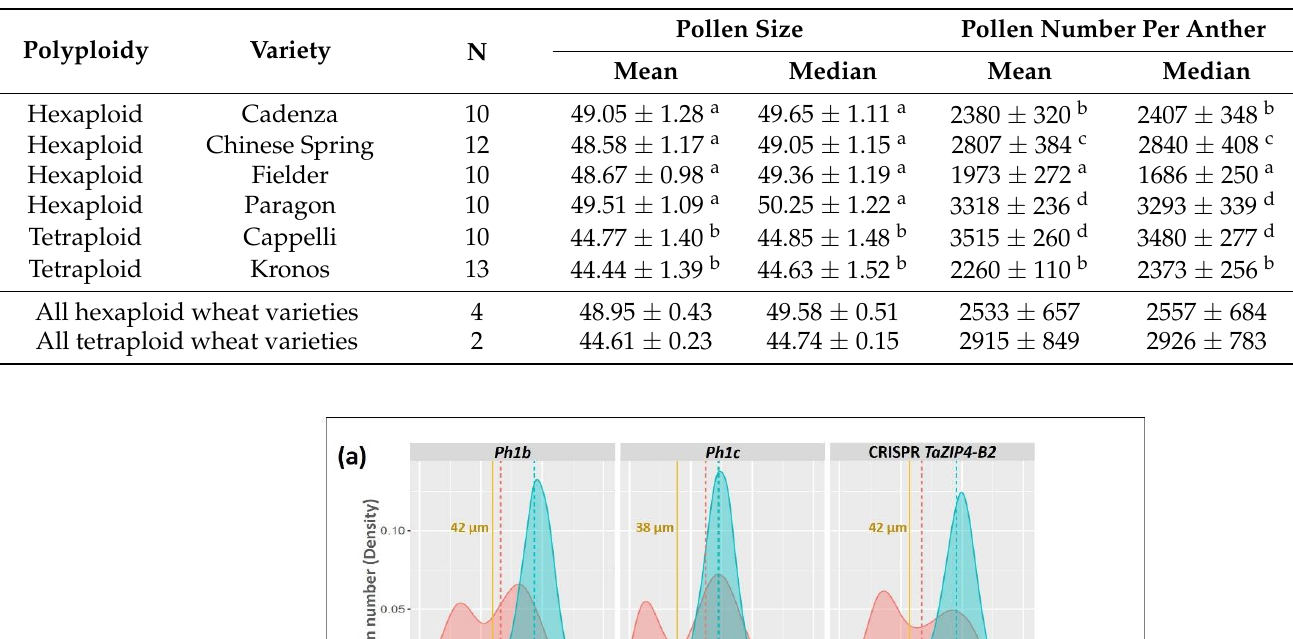
Table 3. Pollen number and pollen grain size for some hexaploid and tetraploid wheat varieties. Mean and median values with standard deviations are shown. Treatments with the same letter are not significantly different.